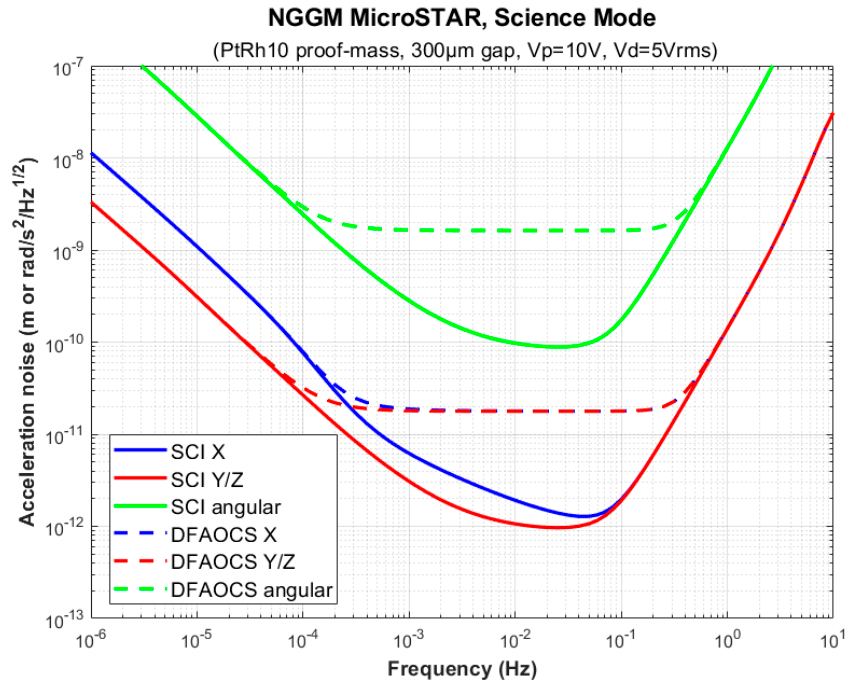
Figure 11. Worst-case analysis (WCA) of the acceleration measurement noise for linear and angular accelerations for the science output (SCI) or for DFAOCS outputs. Performance is shown for the X axis (less sensitive) and for Y/Z axes (ultra-sensitive) of the accelerometer reference frame. Table 3. Bias, scale factor, quadratic factor, and misalignments of the MicroSTAR accelerometer (in the accelerometer reference